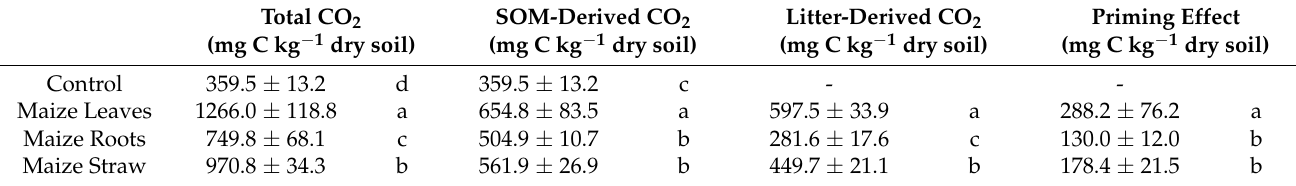
Values represent means (n = 5, for Control n = 4) ± standard deviation. Different letters in the same column indicate a significant